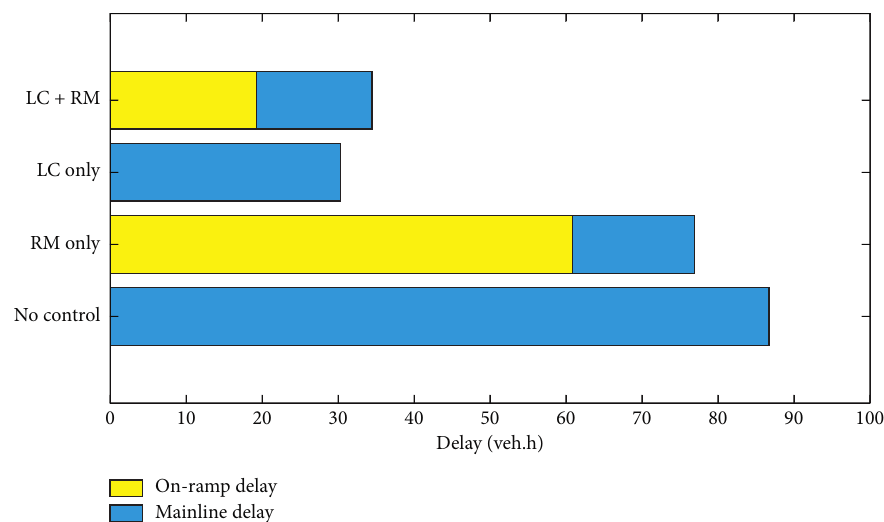
Figure 4: Delays upstream of the merging point on the two